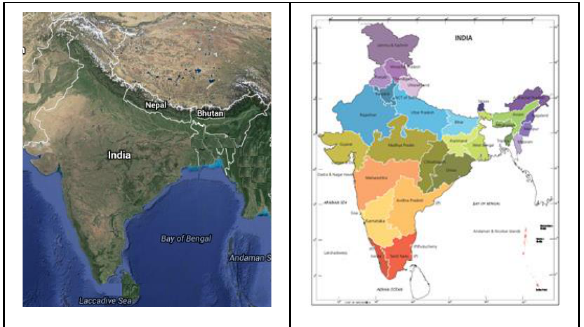
Figure 1 and 2. 3-D Physiographic Features for India and Administrative Division by States of India, 2011, respectively.